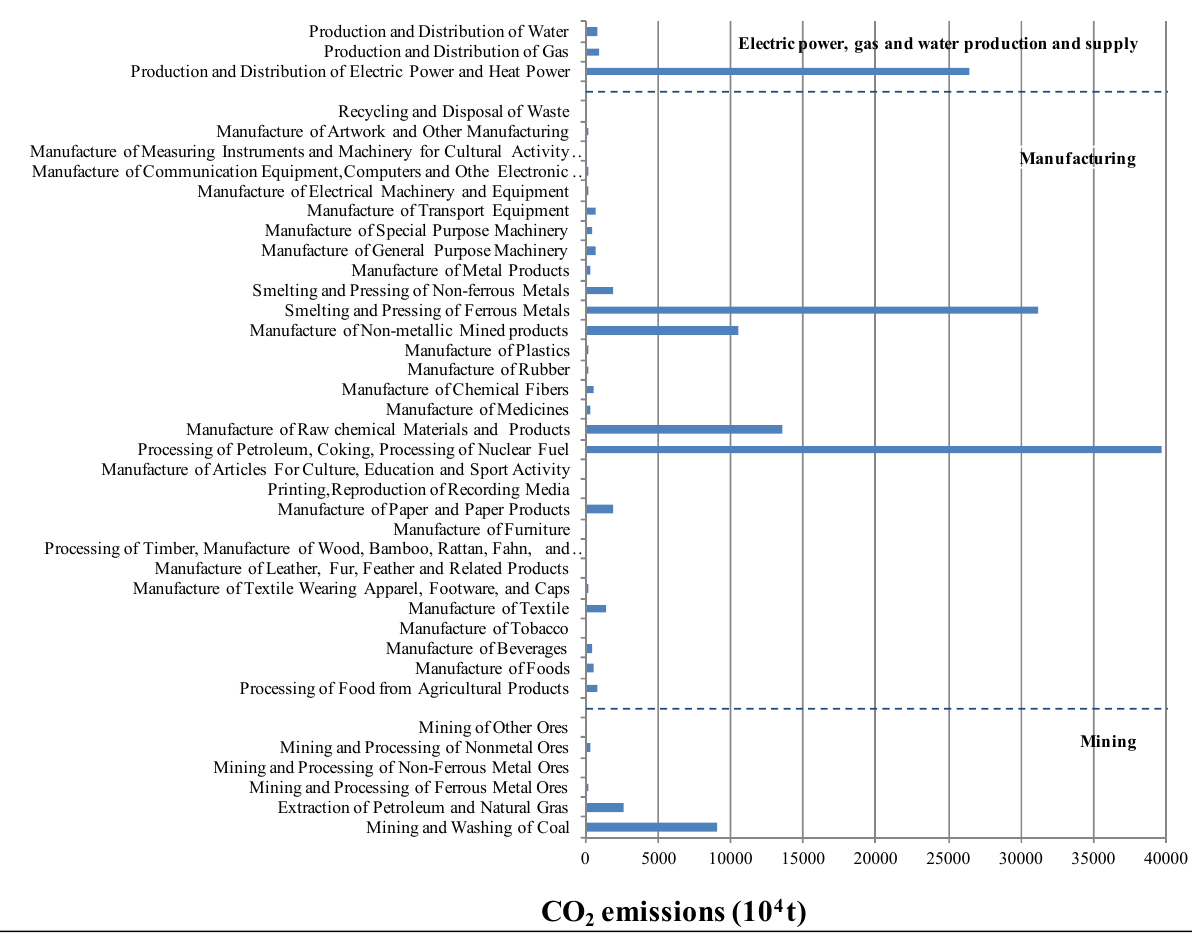
Figure 3. The distribution of carbon emissions from industrial internal sectors in